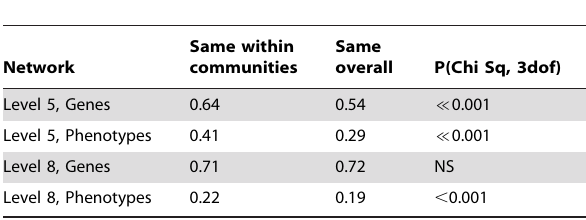
Table 1. Frequencies with which gene pairs within Newman communities share level 1 MP terms compared to frequencies for all genes.